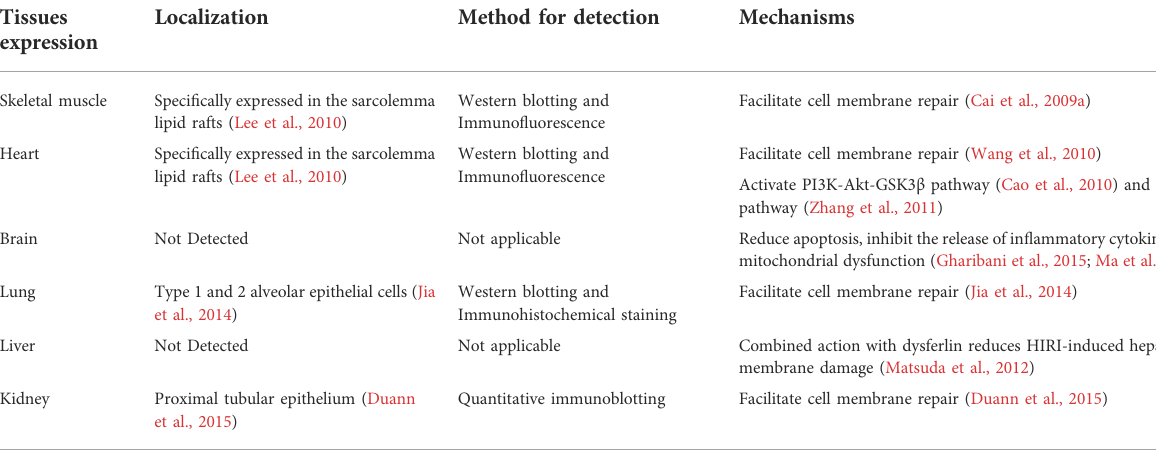
TABLE 1 List of studies on the role of MG53 in multiple organs. Tissues